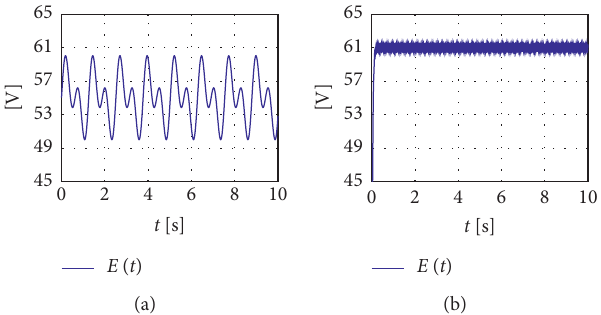
Figure 3: Renewable energy emulation of the power supply E ( t ) . (a) Waveform described by equation (17) and contains variations that could emerge from the usage of a renewable energy source. (b) Time-varying function proposed in equation (18) with variations that may appear in a photovoltaic module with constant